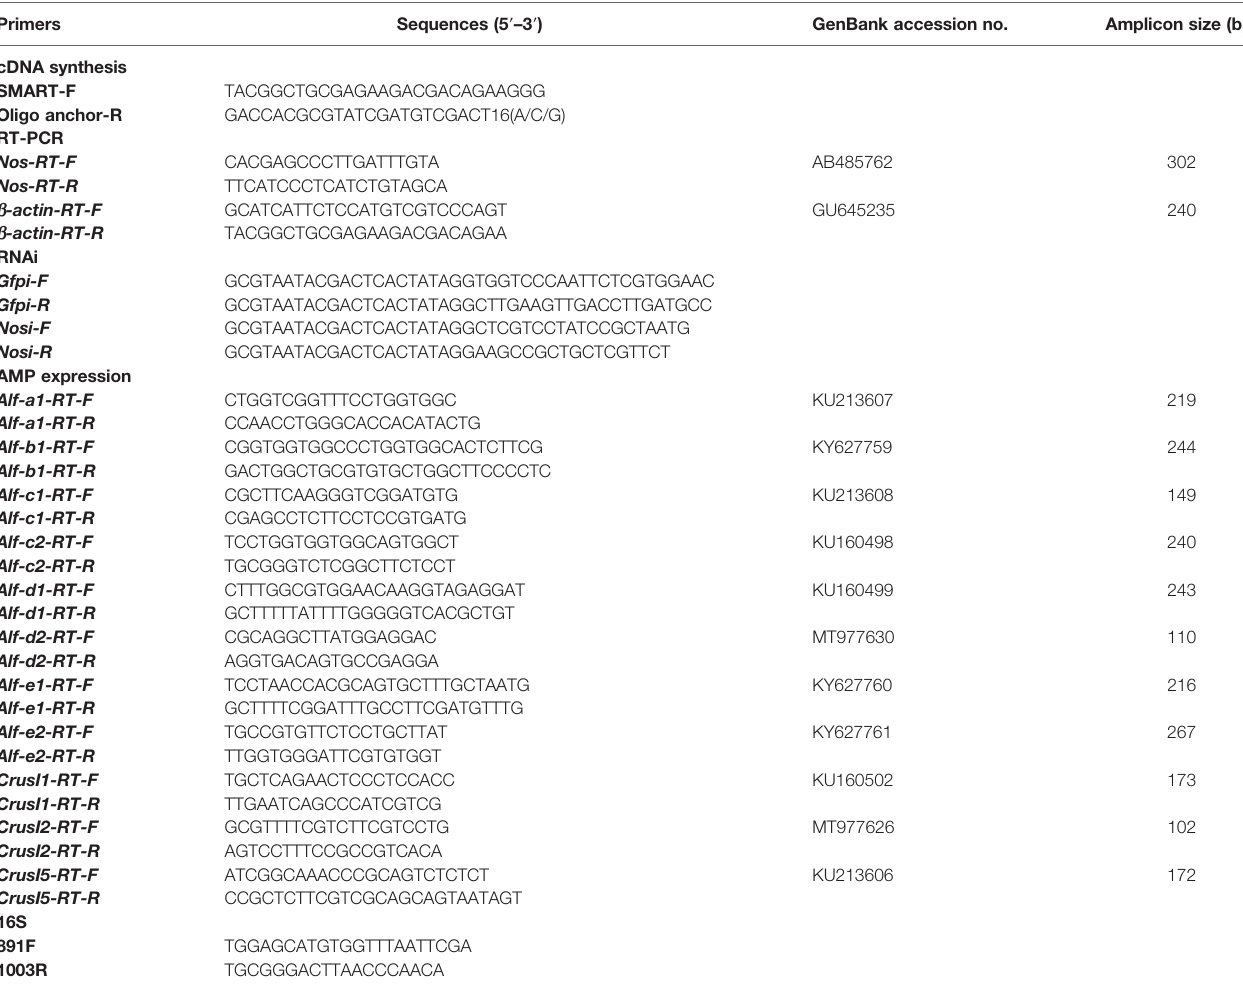
TABLE 1 | Sequences of primers used in this